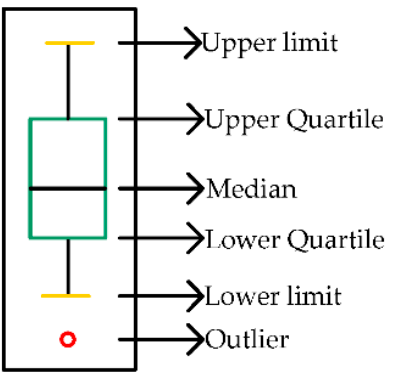
Figure 2. A schematic diagram of the box plot.